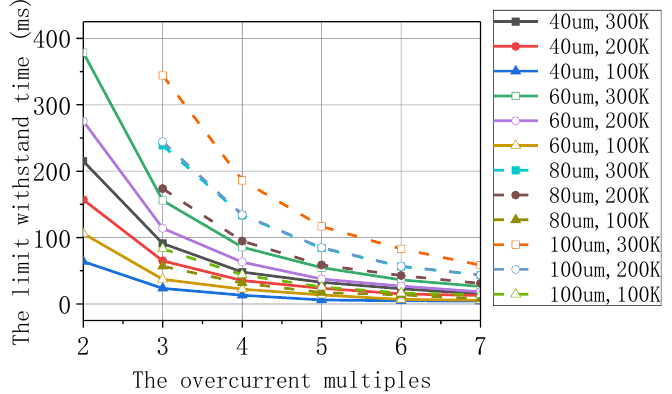
Figure 15. Impact boundary curves under different reinforcement layer thicknesses.